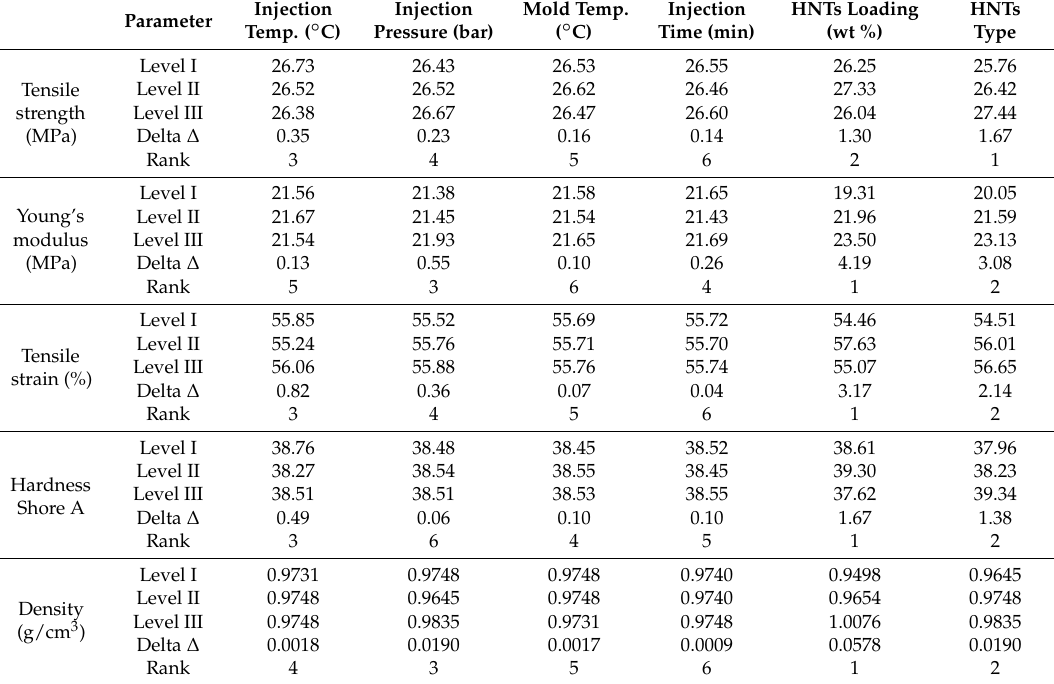
Table C1. Response table for S/N ratios “larger is better” for